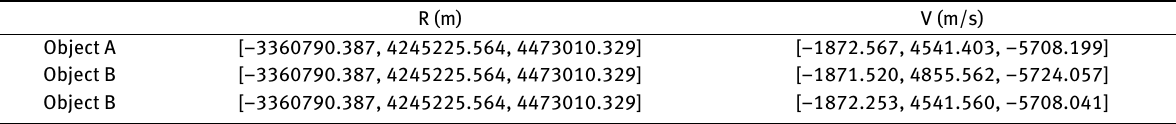
Table 2. The initial positions and velocities of debris objects in the inertia space.